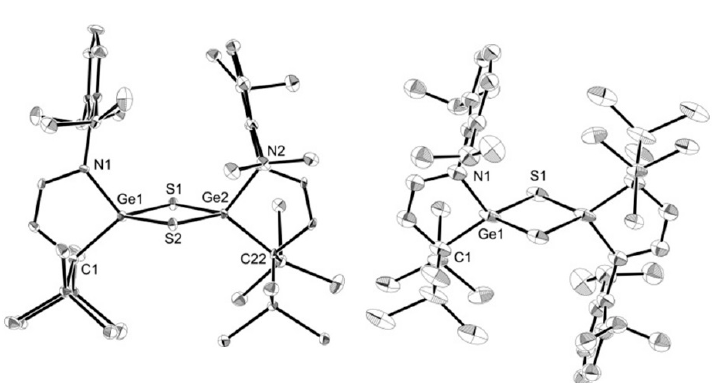
Figure 6. Solid state structures of 6a ( left ) and 6b ( right ). Hydrogen atoms are omitted for clarity. Thermal ellipsoids are shown at the 50% probability level.